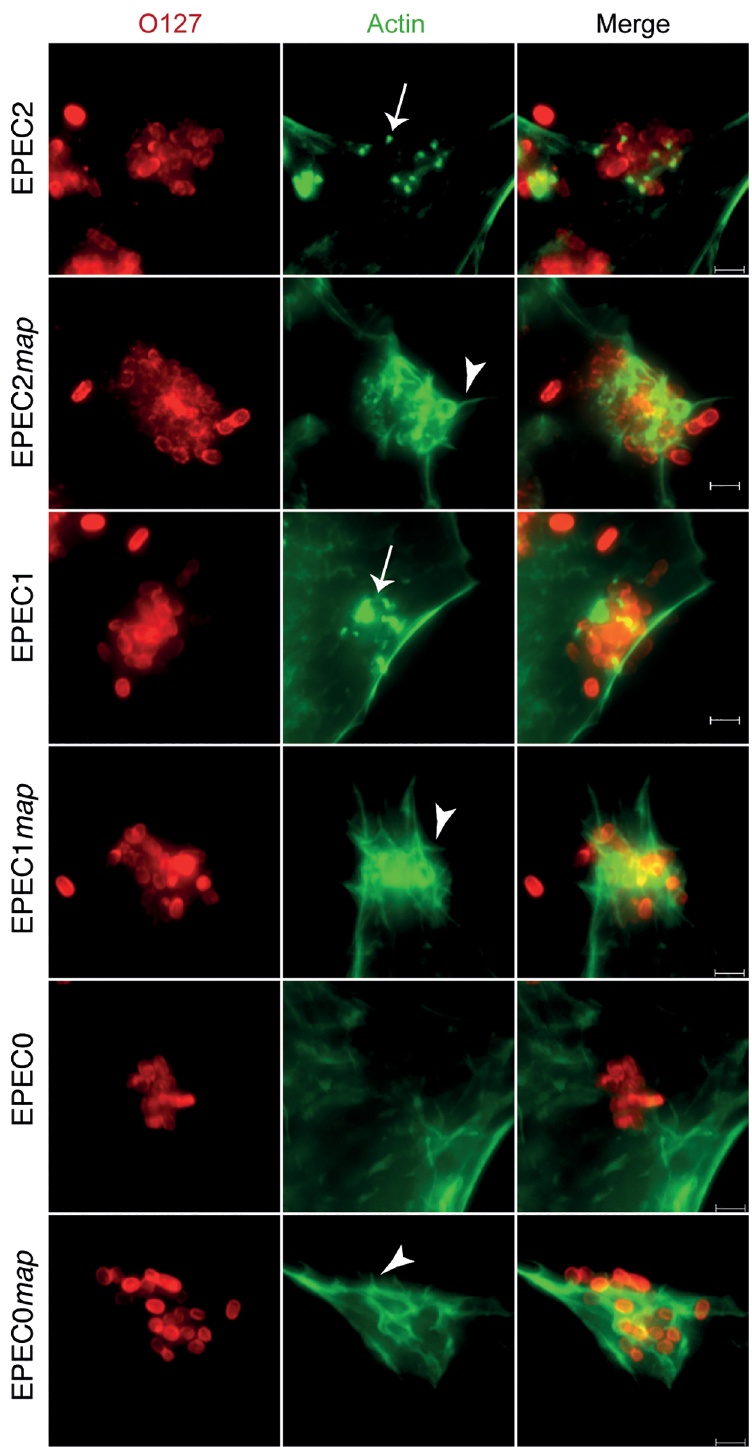
Fig 3. Induction of filopodia by EPEC effector mutants with integrated map . Immunofluorescence microscopy of Swiss 3T3 cells infected for 10 min with EPEC2, EPEC1 and EPEC0 and isogenicstrains with map integratedin the chromosome. EPEC was detected with rabbit polyclonal anti-O127 (red) and actin was stainedwith Oregon-green phalloidin(green). Filopodiaspikes are labelledwith arrowheads. Actin accumulation beneathbacteria is indicatedwith arrows. Scale bar 2 μ